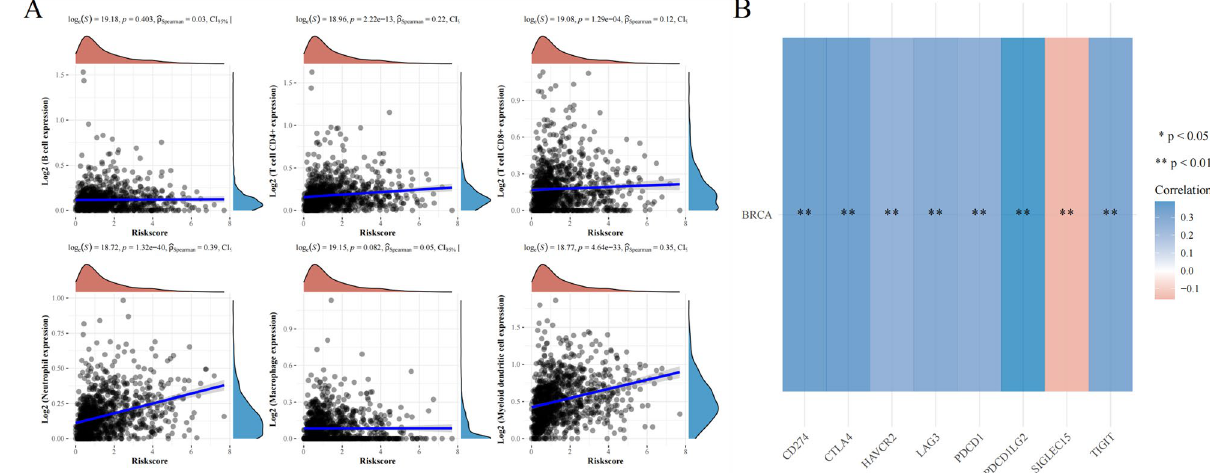
Figure 13. ( A ) The relationship between GSDMC expression levels and immune cell infiltration in BRCA via TCGA database; ( B ) the relationship between GSDMC expression levels and immune checkpoints in BRCA via TCGA database. * P < 0.05, ** P < 0.01, *** P <